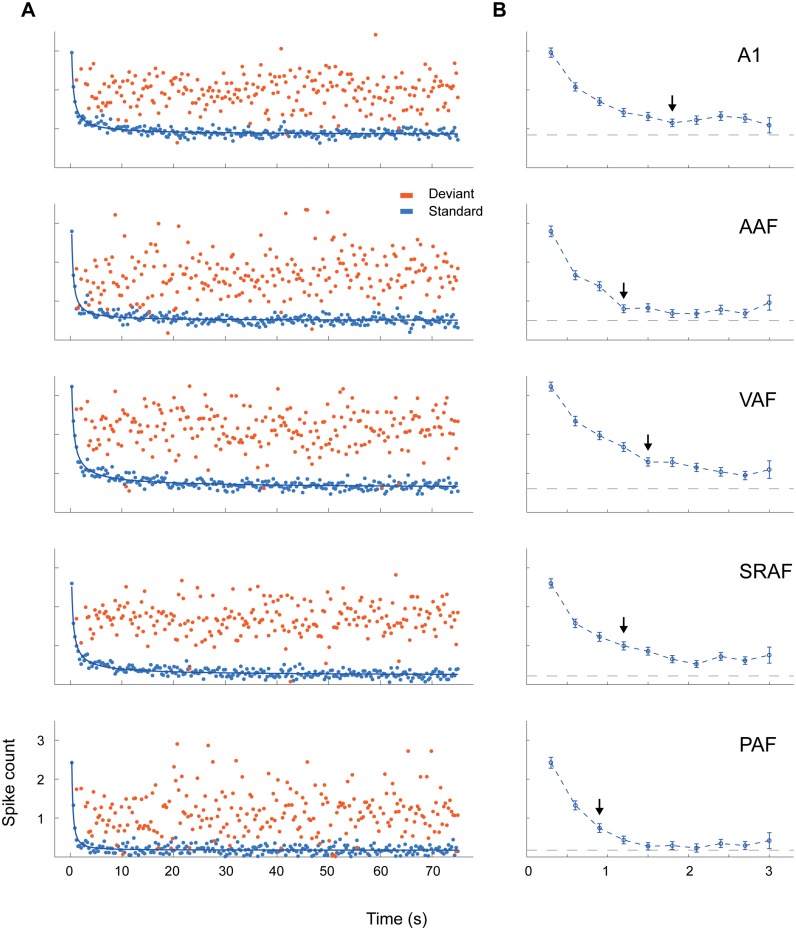
Time course of adaptation within each field.
A. Average responses within each auditory cortex field in relation to the order of tone presentation, plotted for standard (blue) and deviant (red) tones separately. The course of standard responses over time followed a power law (thick blue lines), indicating that SSA matches stimulus statistics at many timescales. B. Detail of the average (mean ± SEM) standard responses for the first 10 presentations within the sequence. The arrows indicate the trial number in which the response has fallen significantly below half of the response to the first tone presentation. Gray dashed lines indicate the steady-state plateau reached by standard responses at the end of the sequence (constant parameter of the power-law fit). Adaptation occurred faster in PAF than in any other field (see text), and reached a much lower plateau in nonprimary than in primary fields. Underlying data for this figure can be found in S6 Data.